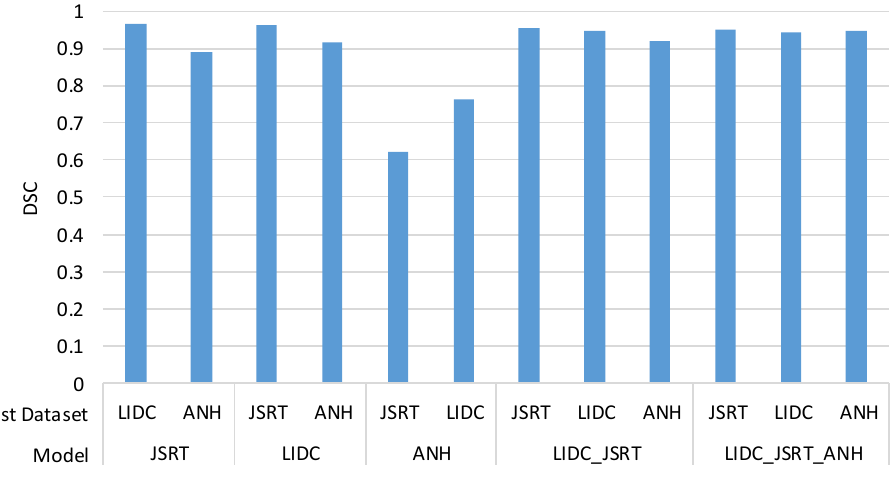
Figure 12. Cross-dataset test results of the DSC metric.